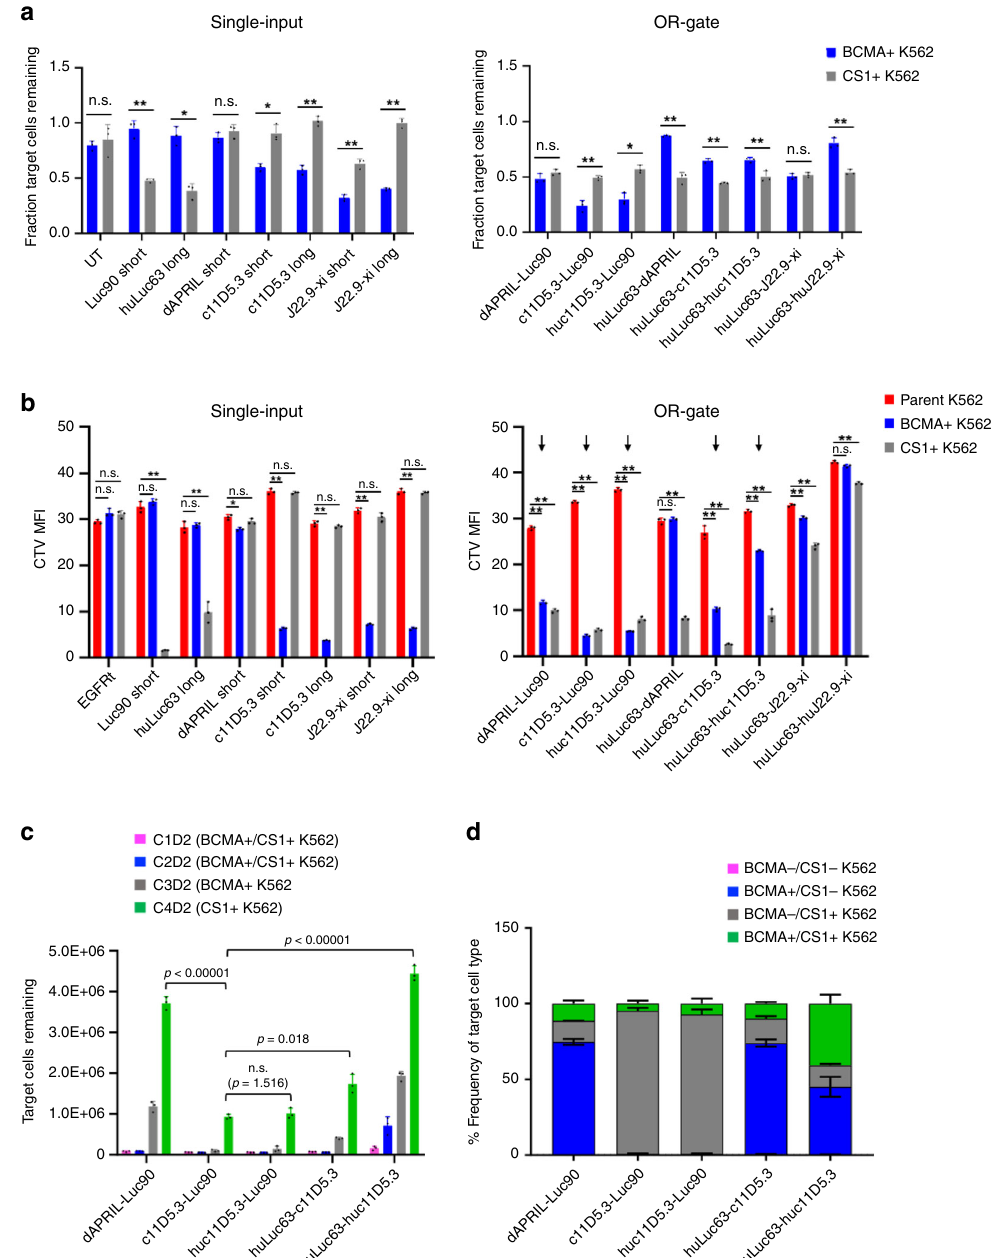
Fig. 2 OR-gate CAR panel exhibits range of ef fi cacy against BCMA + and CS1 + targets. a Cell-lysis activity of single-input and bispeci fi c CD8 + CAR-T cells against K562 targets engineered to express either BCMA or CS1. Cells were seeded at an effector-to-target (E:T) ratio of 2:1, where effector-cell seeding was based on CAR + T-cell count. The fraction of viable K562 cells left after a 20-h coincubation was quanti fi ed by fl uorescence imaging of target cells using IncuCyte. All bispeci fi c CARs in this panel contained a short extracellular spacer. b Proliferation of single-input and bispeci fi c BCMA/CS1 CD8 + CAR-T cells upon antigen stimulation. CAR-T cells were stained with CellTrace Violet (CTV) dye. CTV median fl uorescence intensity (MFI) was quanti fi ed by fl ow cytometry after a 5-day coincubation with parental (BCMA − /CS1 − ), BCMA + , or CS1 + K562 target cells at a 2:1 E:T ratio. CARs containing huLuc63 paired with dAPRIL, J22.9-xi, and huJ22.9-xi were subsequently eliminated from the panel based on poor cytotoxicity and/or T-cell proliferation. c Cytotoxicity of reduced bispeci fi c CAR-T-cell panel upon repeated antigen challenge. CD8 + CAR-T cells were coincubated with K562 target cells at a 1:1 E:T ratio and rechallenged every 2 days with fresh target cells. Viable target-cell count was quanti fi ed by fl ow cytometry 2 days after each target-cell addition. ‘ C# ’ denotes the challenge number and ‘ D# ’ denotes the number of days post challenge. d Characterization of the remaining K562 target-cell populations after four challenges from c reveals differing antigen preference among the panel of bispeci fi c CARs. Values shown are the means of technical triplicate samples, with error bars indicating + 1 standard deviation (SD). P -values were calculated by unpaired two-tailed Student ’ s t -test; n.s. not statistically signi fi cant ( p > 0.05); * p < 0.05; ** p < 0.01, with Bonferroni correction for multiple comparisons applied. P- values in c were calculated for the fi nal time point for each construct, relative to the top-performing CAR, c11D5.3-Luc90. Source data are provided as a Source Data File. P -values in a and b can be referenced in the Source Data